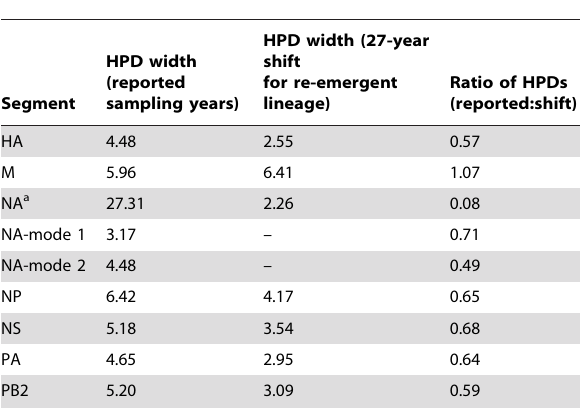
Table 1. Highest posterior density (HPD) width in years of the node leading to the re-emergent H1N1 lineage before and after a 27-year shift in sampling dates.